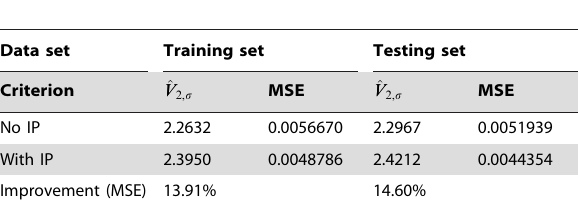
Table 1. Performance comparison for the FNN using ‘‘MG’’. Table 2. Performance comparison for the FNN using